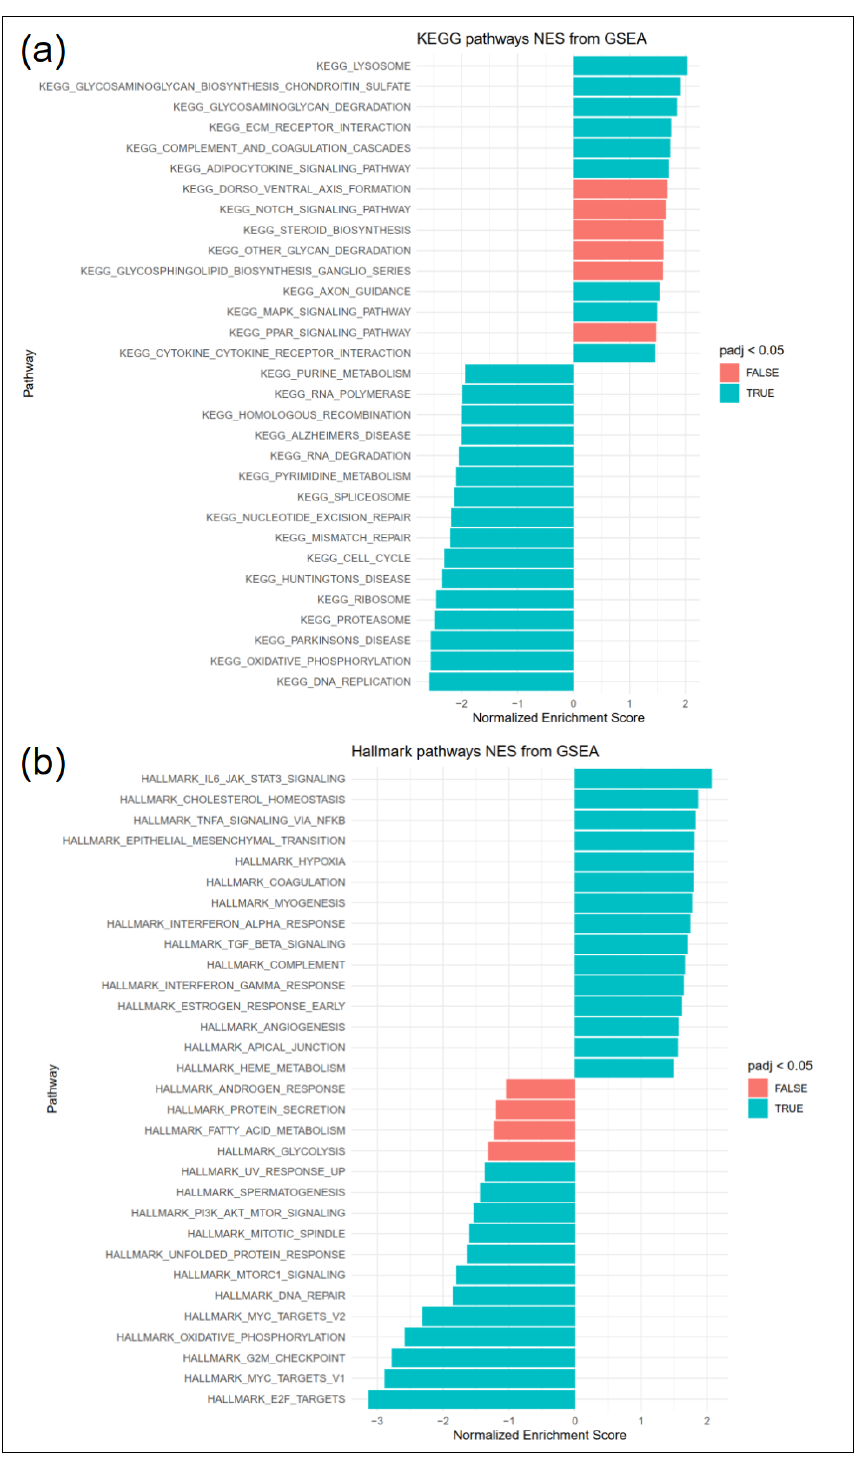
Figure 5. FGSEA pathway analysis revealed significantly regulated ( a ) KEGG and ( b ) hallmark pathways, 15 top and bottom regulated pathways are shown (blue padj < 0.05, red padj > 0.05). 3.6. RE VFFs Have Increased Levels of Inflammatory Cytokine Receptors IL1R1 and IL6R To assess glycosaminoglycan turnover, CSGALNACT2 , GLB1 and GALNS were cho- sen for qPCR-based expression analysis but were not significantly deregulated (Supple- mentary Figure S2b). Likewise, the gene expressions of the transcription factor STAT3, a